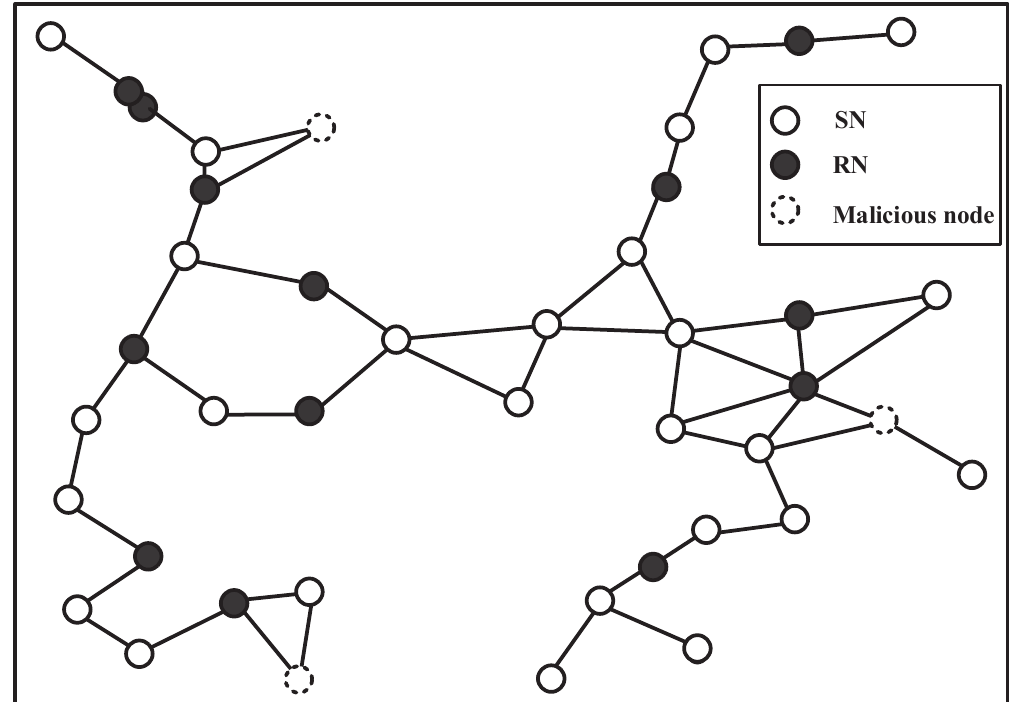
Figure 4. A network with 27 honest sensor nodes, 13 relay nodes and three attackers.